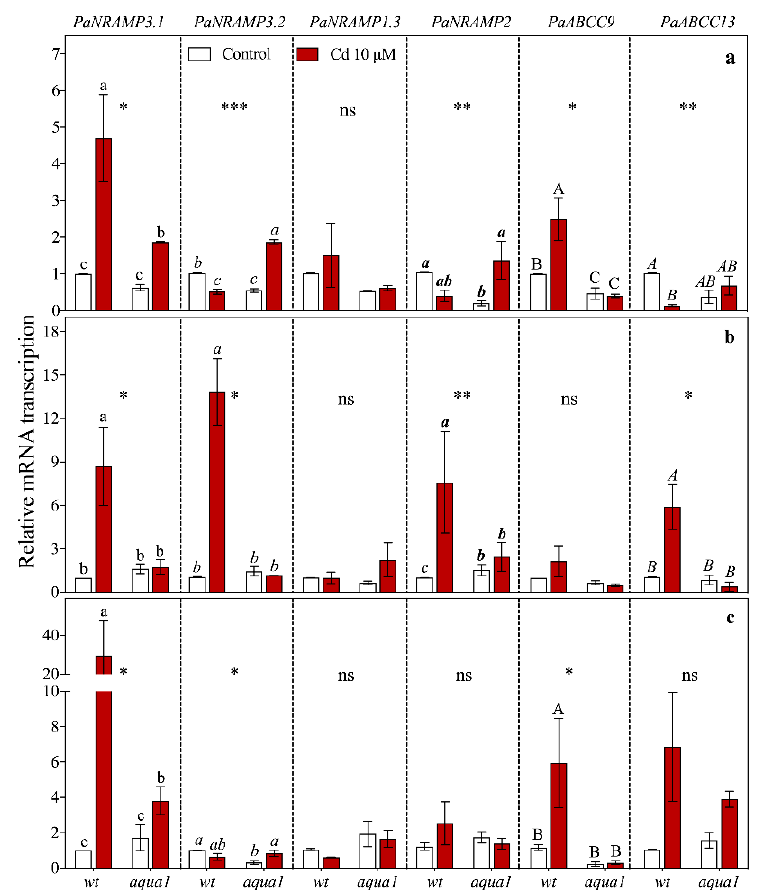
Figure 5. Gene relative transcript abundance in leaves ( a ), stem ( b ), and root ( c ) at 1 d of treatment. Values represent the mean of three biological replicates ± SE. Data were analyzed with two-way ANOVA; p -values correspond to the interaction between Cd and Line are reported in the figure (* = 0.01 < p < 0.05, ** = 0.001 < p < 0.01, *** = p < 0.001, ns = not significant). When the interaction was significant, different letters indicate significant differences among treatments at each sampling time and organ. Cd and Line p -values are reported in Supplementary Materials Table S3.